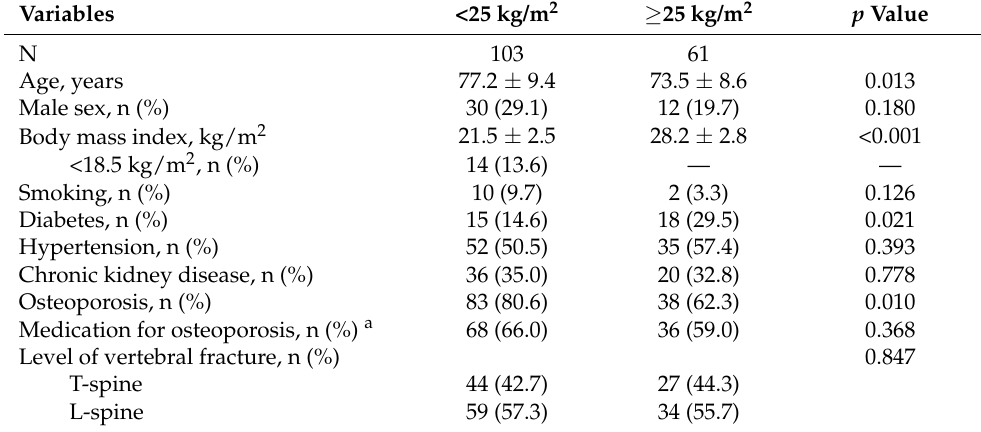
Table 1. Baseline characteristics of the study sample according to body mass index.